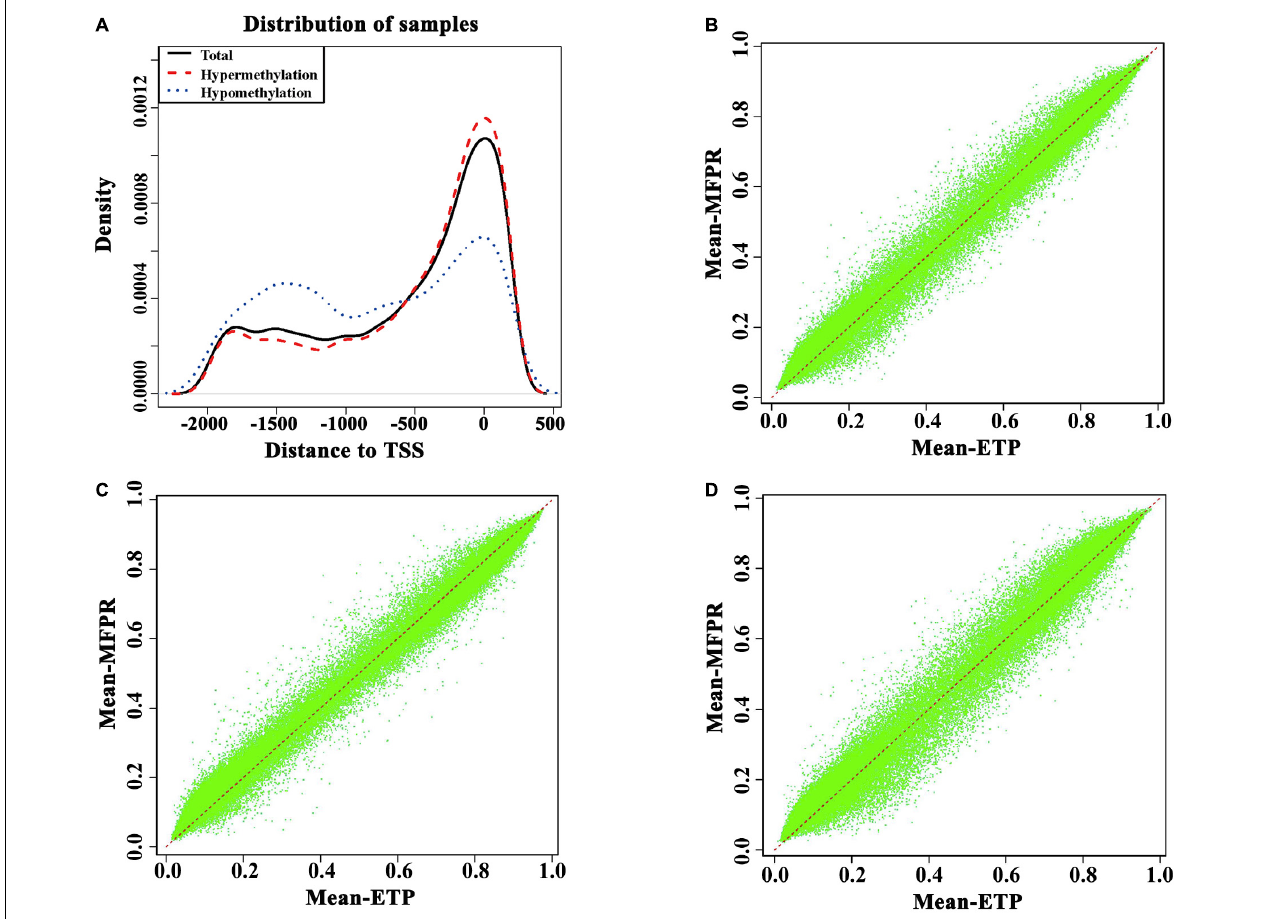
FIGURE 3 | Differential methylation near transcription start sites (TSS) and promoters. (A) Density plots of the DMRs in TSS –2,000 to 500. Hypermethylation (red curve) represents the density curve where the mean beta is greater in the MFPR group than in the ETP controls. Hypomethylation (blue curve) represents the density curve where the mean beta is lower in the MFPR group than in the ETP controls, and total (black curve) represents the density curve at all loci. (B) Annotation of the promoter methylation density between the ETP vs. MFPR groups. (C) Annotation of the promoter methylation density between the ETP female vs. MFPR female groups. (D) Annotation of the promoter methylation density between the ETP male vs. MFPR male